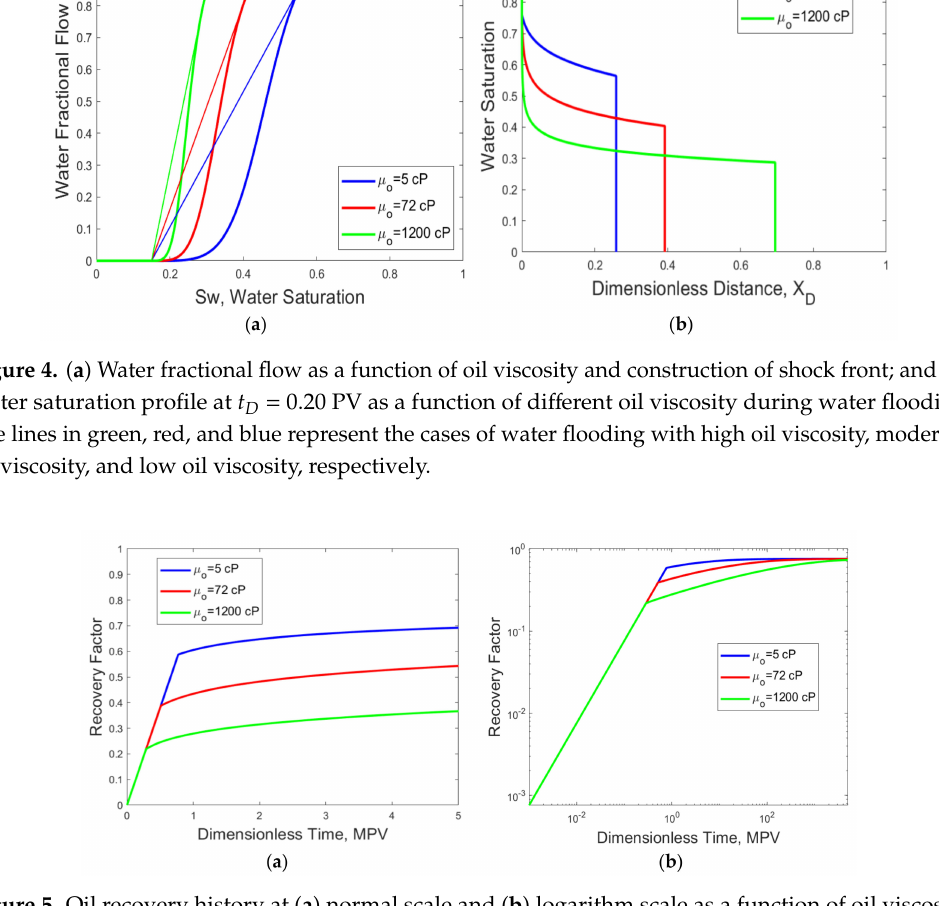
Figure 5. Oil recovery history at ( a ) normal scale and ( b ) logarithm scale as a function of oil viscosity during water flooding. The lines in green, red, and blue represent the cases of water flooding with high oil viscosity, moderate oil viscosity, and low oil viscosity,